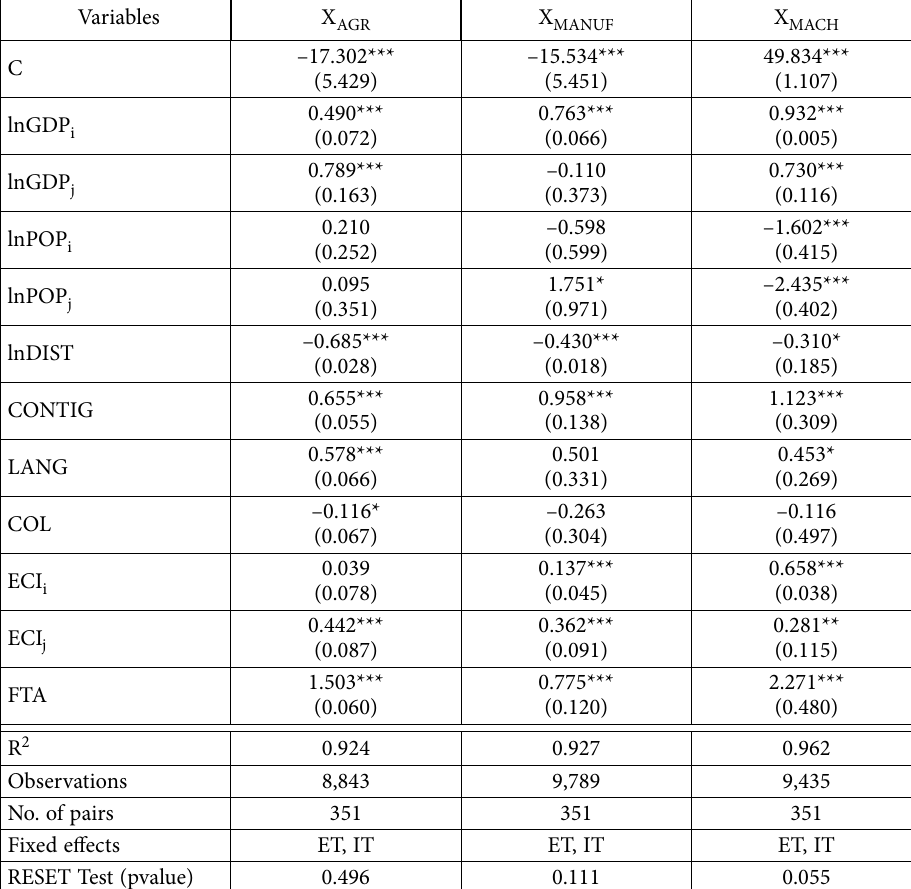
Table 6. Gravity model estimates of bilateral exports using PPML for all